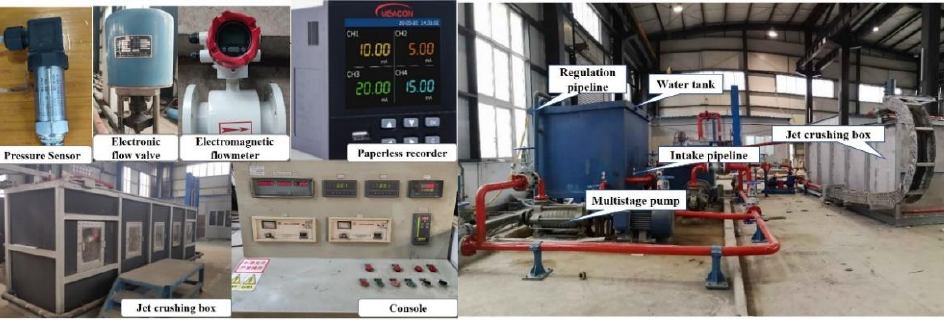
Figure 12. Experimental equipment.